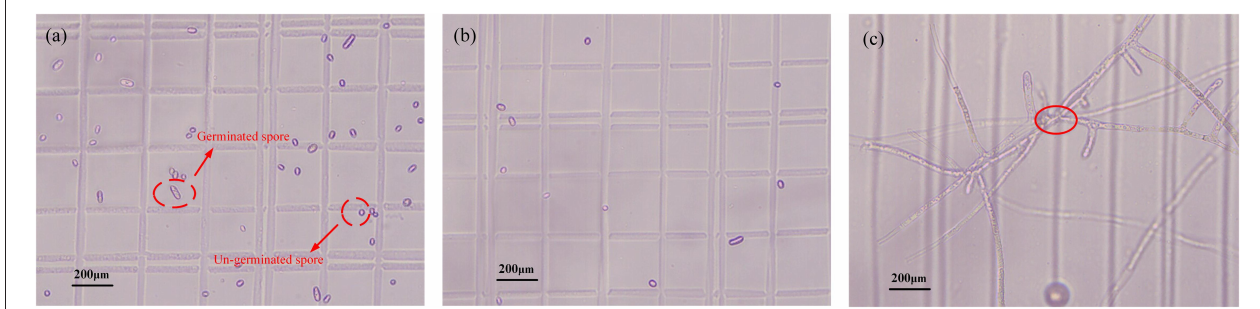
FIGURE 2 | Spore germination of Penicillium (at a magnification of 400 times). (a) The control group, (b) after PAW treatment, and (c) spores that grew into hyphae after prolonged